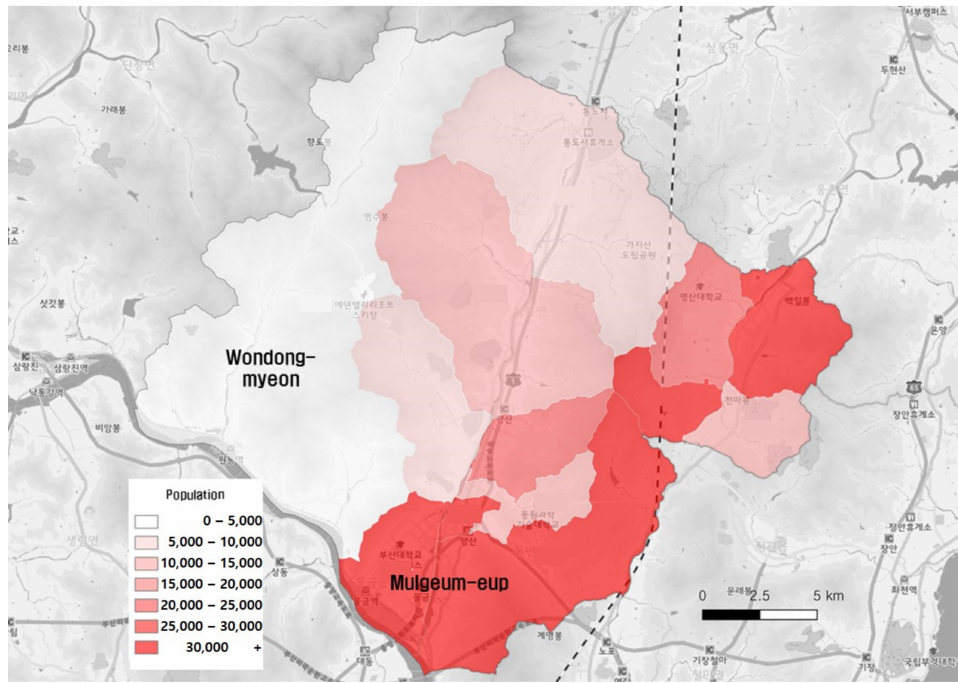
Figure 4. Population distribution in Yangsan-si.